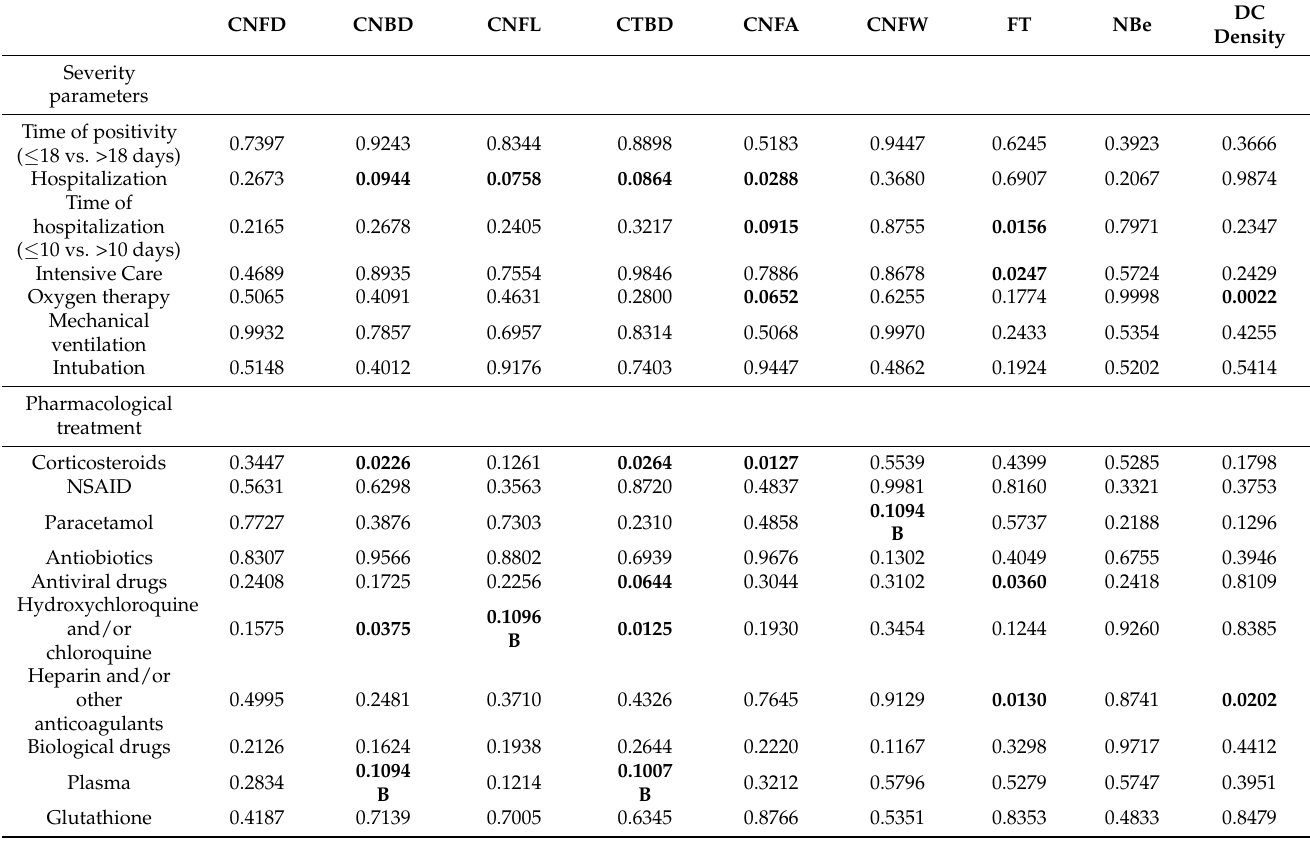
Table 3. Corneal confocal microscopy data in COVID-19 patients, according to disease severity and therapies ( p -values from univariate